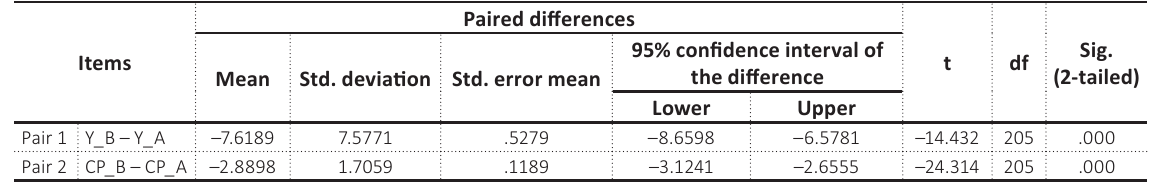
Paired differences